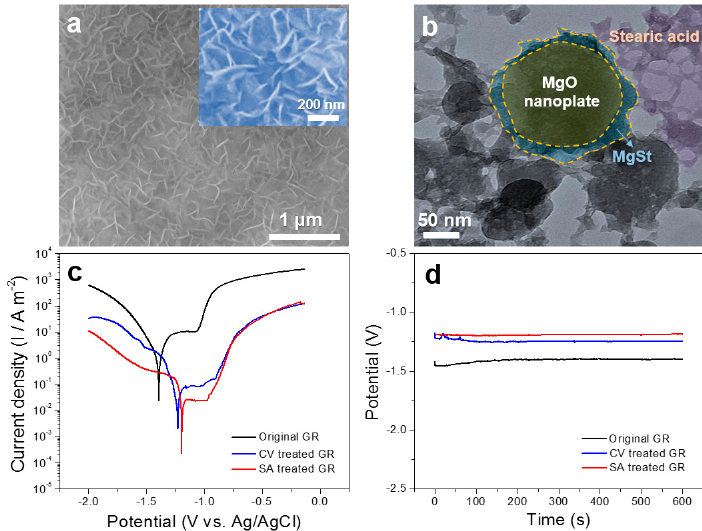
Figure 9. ( a ) BSE image and ( b ) TEM image of the hydrophobic film; ( c ) polarization curves and ( d ) open circuit potential of samples treated in different ways. Nanomaterials 2020 , 10 , x FOR PEER REVIEW